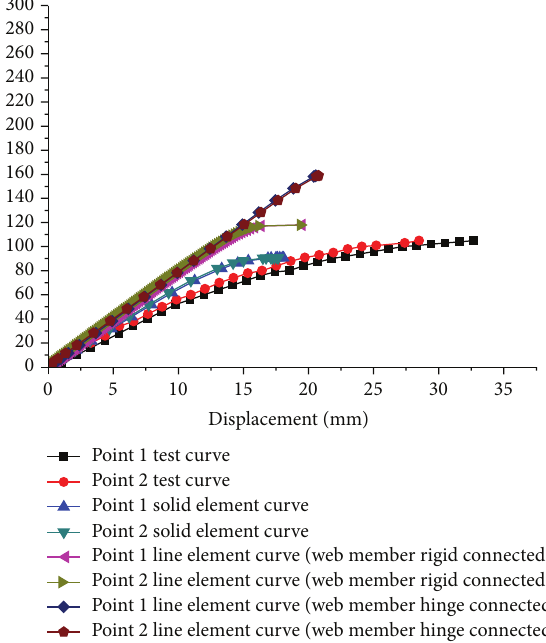
Figure 17: Load-displacement curves at column